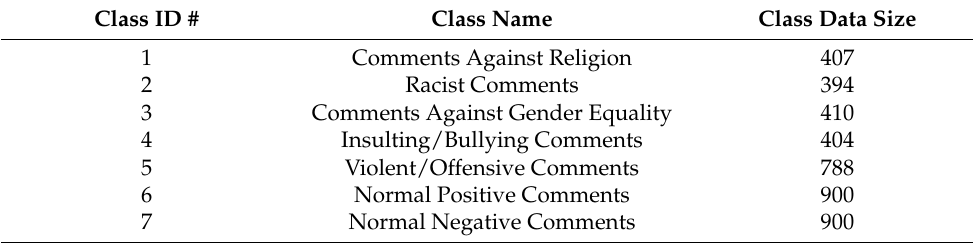
Figure 1. Workflow of the proposed system for hate speech detection from Arabic text. Table 2. Summary of the newly constructed class and data size for hate speech